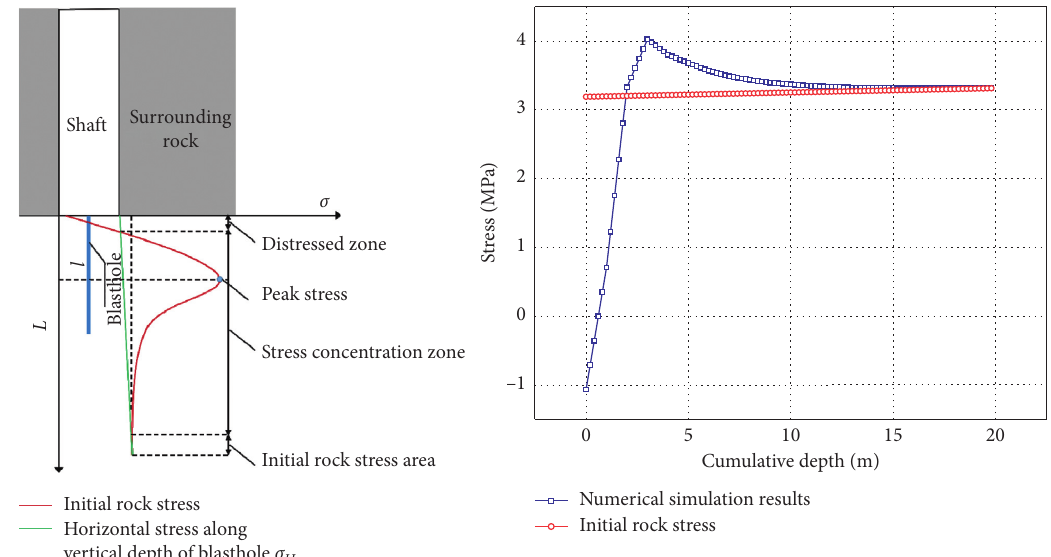
Figure 1: Horizontal stress distribution and horizontal stress simulation results.